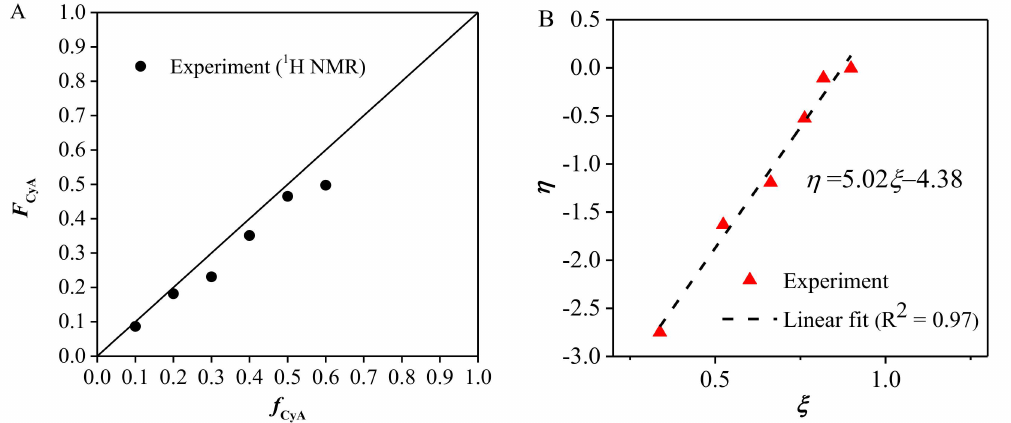
Figure 1. ( A ) Dependence of the instantaneous copolymer composition F CyA on the initial comonomer feed composition f CyA . The solid line represents a random copolymerization, where r 1 = r 2 = 1. ( B ) Calculation of reactivity ratios for the copolymerization of CyA and n BA using Kelen-Tüdös